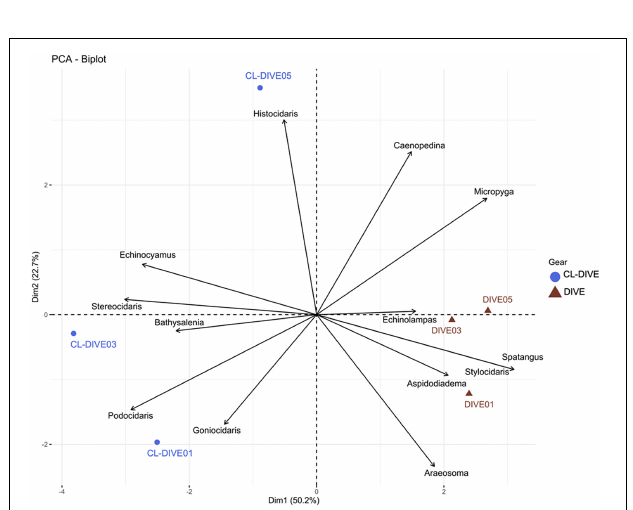
FIGURE 10 | Comparison of asteroid assemblages between imagery (dive) and sampling along dive (cl-dive) along volcanic island slopes (Mayotte) (57.6% of variance on first two PCs). Principal Component Analysis (PCA) of Hellinger-transformed presence/absence asteroid data at genus rank.